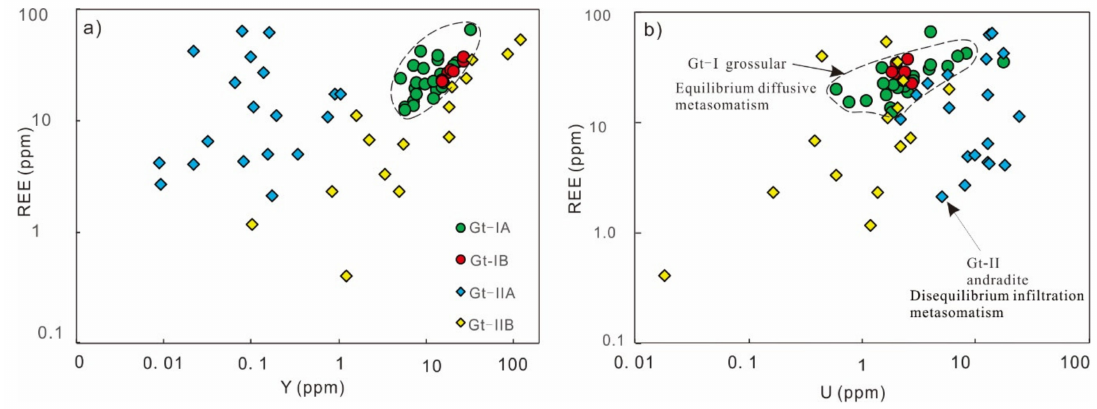
Figure 10. REE and U, Y diagrams of di ff erent types of garnets from the Zhuxiling W (Mo) deposit. ( a ) shows Y(ppm) versus REE (ppm) diagram and ( b ) shows U(ppm) versus REE (ppm)